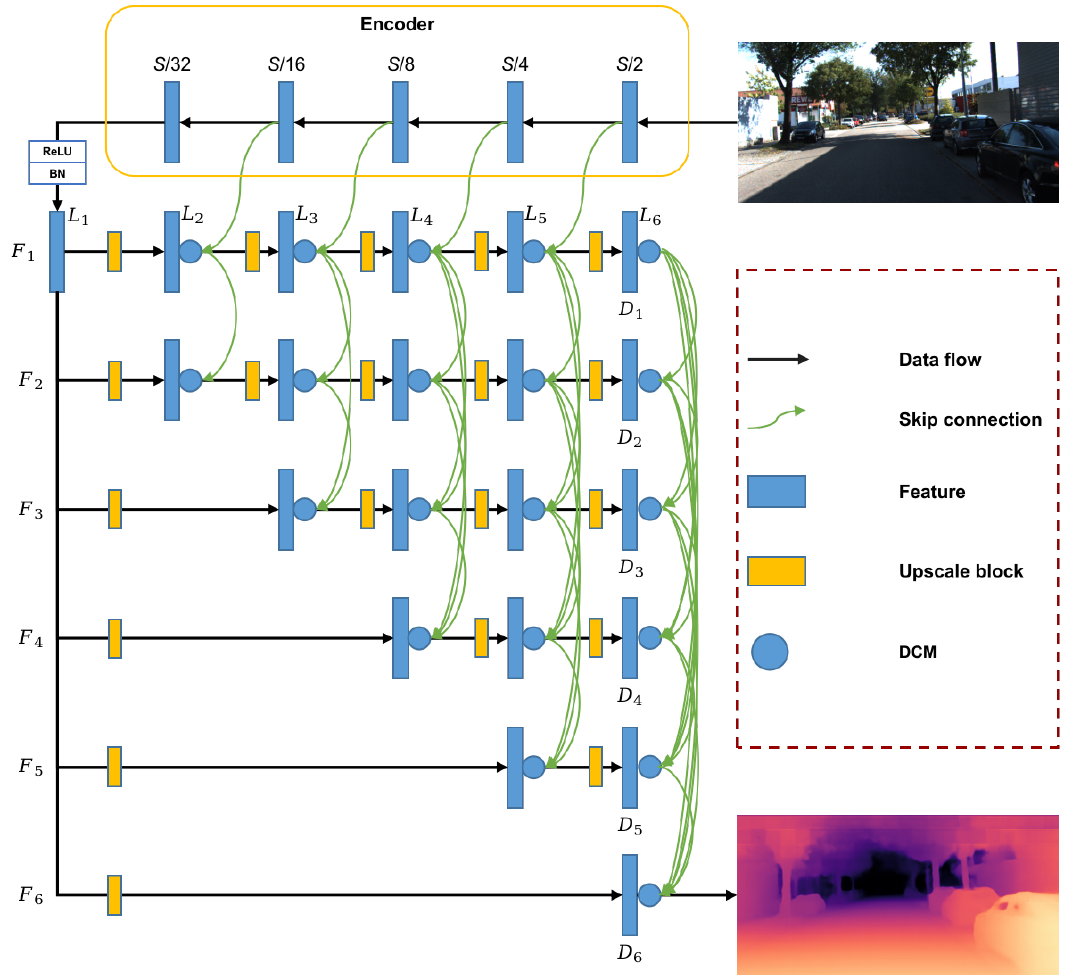
Figure 2. The overall architecture of the proposed network. S indicates the spatial resolution of the input color image. F 1 ~ F 6 denote floors of the pyramid structure. L 1 ~ L 6 denote layers in every floor, and some layers do not exist on specific floors. The resolution of the features on the last layer of every floor is S (i.e., D 1 ~ D 6 , whose resolution is the same as the input image). The blue circles indicate dense connection module (DCM), which will be described in detail in Section